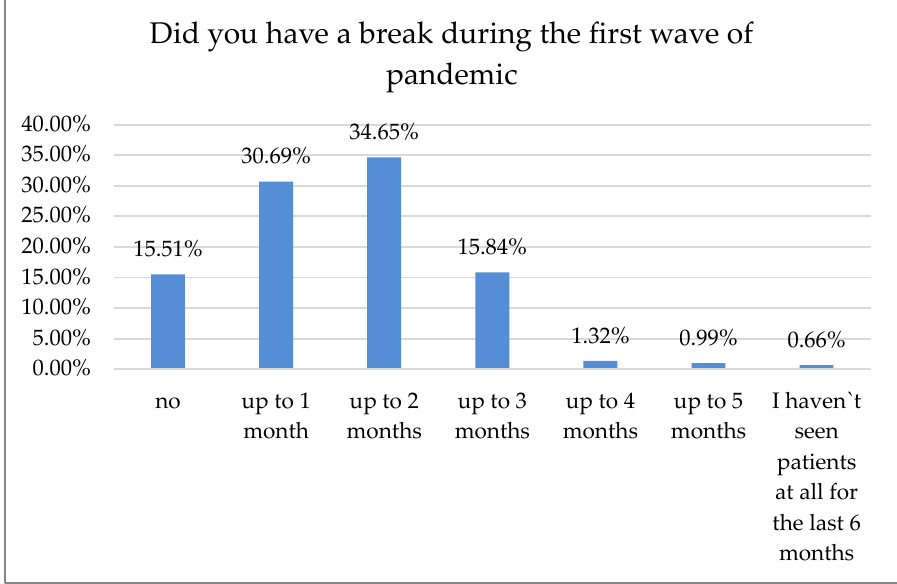
Figure 4. The length of a break from work declared by respondents. Of the respondents, 24.09% reported that they had to cease working with magnification due to personal protection (Figure 5).